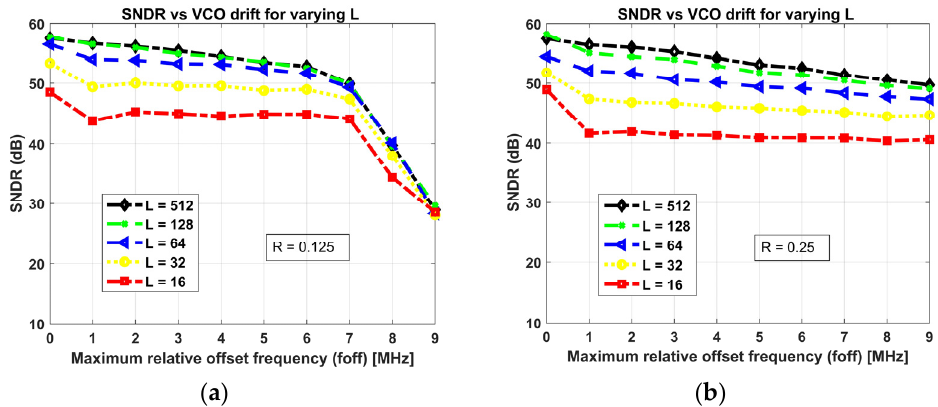
Figure 6. Variation in the simulated output SNDR with the magnitude of maximum relative offset frequency of the two VCOs for varying L and for ( a ) R = 0.125 and ( b ) R = 0.25.